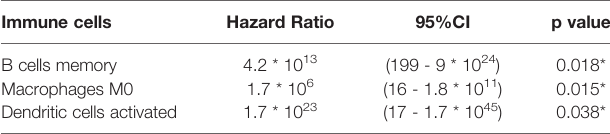
TABLE 2 | Cox proportional hazards regression model including the key members of the immune cells for overall survival in patients with thyroid carcinoma. Immune cells